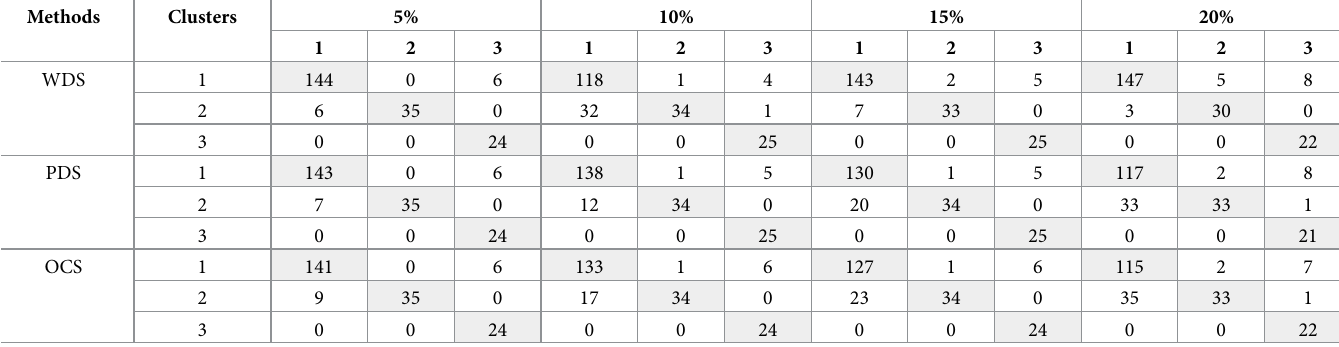
Table 8. Confusion matrices obtained by VKFCM-K-LP with the WDS, PSD and OCS strategies using 5, 10, 15 and 20% of missing values. Methods